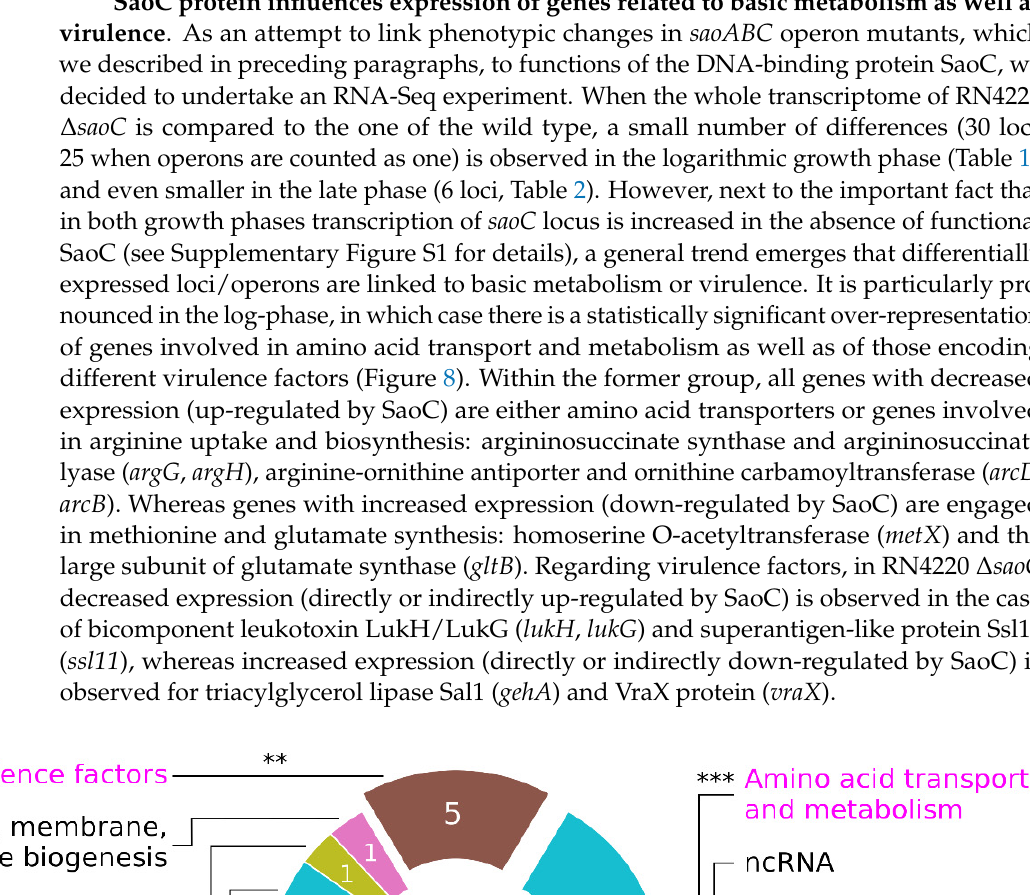
Table 2. Transcripts differentially expressed in RN4220 Δ saoC mutant in the late growth phase. Transcripts are sorted in respect to the fold change value. Negative values indicate fold-decrease in transcription. FDR, false discovery rate ( p value adjusted with Benjamini and Hochberg method). Ontologies are determined based on the transcript type (non-coding RNA, transfer RNA) and COG database (COG IDs given in parentheses).